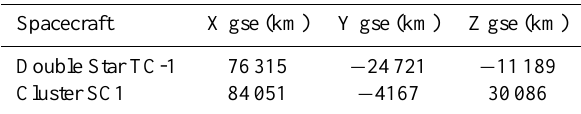
Table 2. Double Star and Cluster spacecraft position at 16 March 2004, 00:20